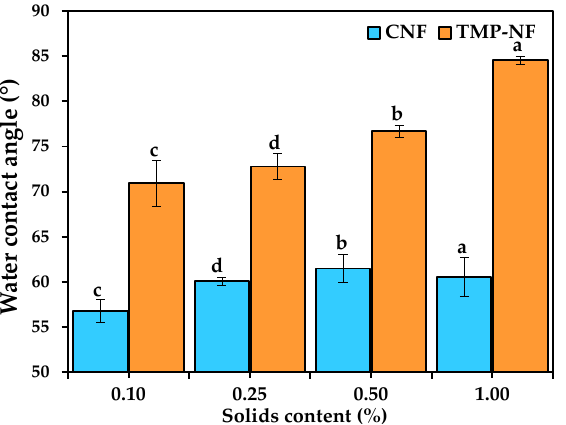
Figure 12. Surface properties of the developed films: Water contact angle. Note: Values are presented as means ± SD. N = 6. Values followed by common letters in the super index indicate estimated significant differences between each pair of means media ( p > 0.05).